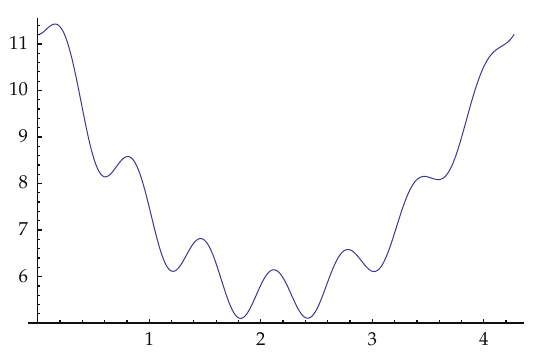
Figure 2: Behaviour of the objective function when D (cid:4) t (cid:5) (cid:6) 2sin (cid:4) 10 t (cid:5) (cid:8) 2cos (cid:4) 10 t (cid:5) (cid:8)